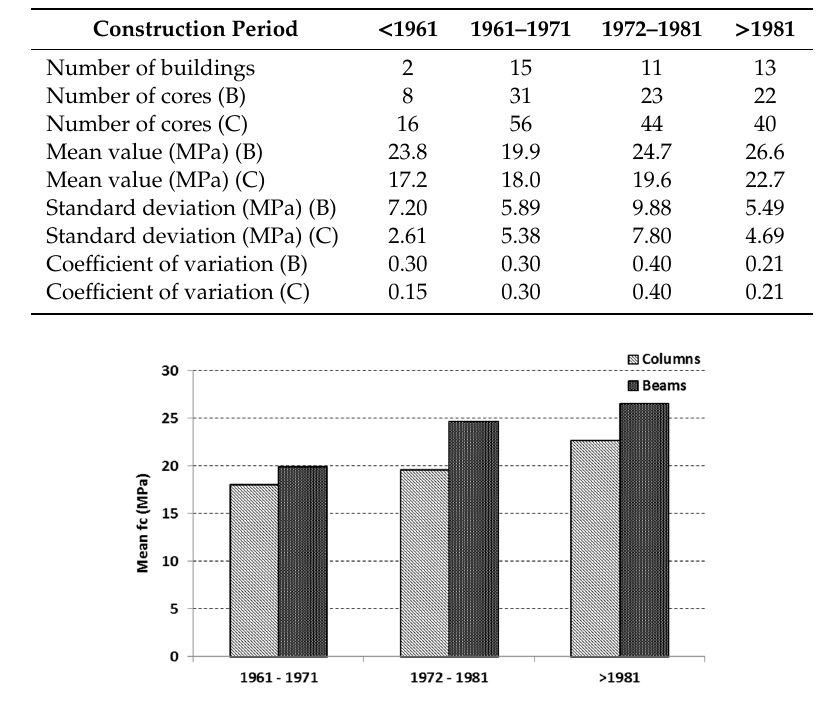
Figure 4. Mean strength values of cores extracted from columns and beams (computed by averaging, in each period, the mean values of the core strength from columns and beams relevant to each single building).